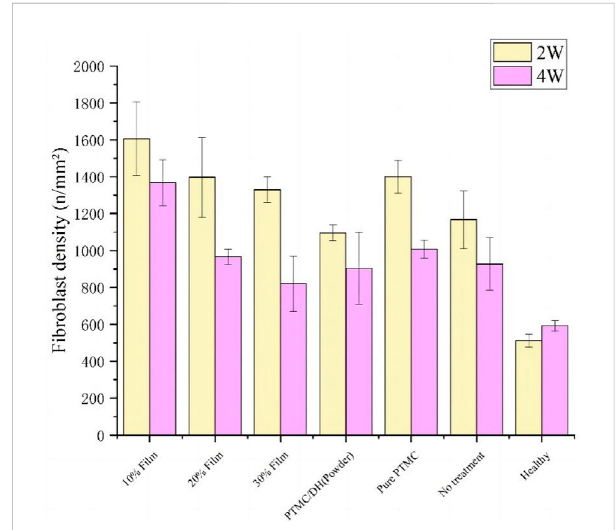
FIGURE 12 Comparisonof fi broblastdensityvaluecountsbetweengroupsat 2 weeks and 4 weeks.